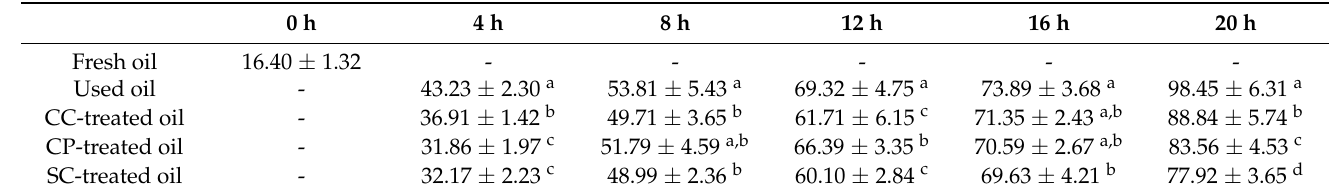
Table 5. p -AV of the used and treated oils with different lignocellulosic biomasses; corn cob (CC), cornstalk piths (CP) and sugarcane bagasse (SC). Means with different letters ( a , b , c , d ) within each column indicate statistically significant differences between the samples after Duncan’s analysis ( p < 0.05). The numbers 4, 8, 12, 16 and 20 indicate the frying period by (h, hours). 0 h 4 h 8